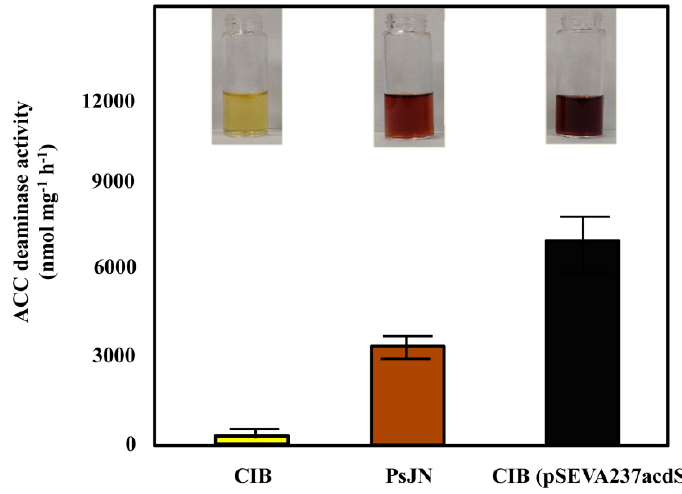
Figure 2. ACC deaminase activity in different bacterial strains. The ACC deaminase activity of Azoarcus sp. CIB (yellow column), P. phytofirmans PsJN (brown column) and Azoarcus sp. CIB (pSEVA237acdS) (dark grey column) was determined according to a colorimetric method described in Section 2. The intensity of the color varies from the yellow (negative) to dark brown (positive). The spectrophotometric method determines the presence of α -ketobutyrate (nmol per mg of total protein − 1 h − 1 ) produced from ACC. Means of three independent experiments are presented and the standard deviation is indicated as error bars.